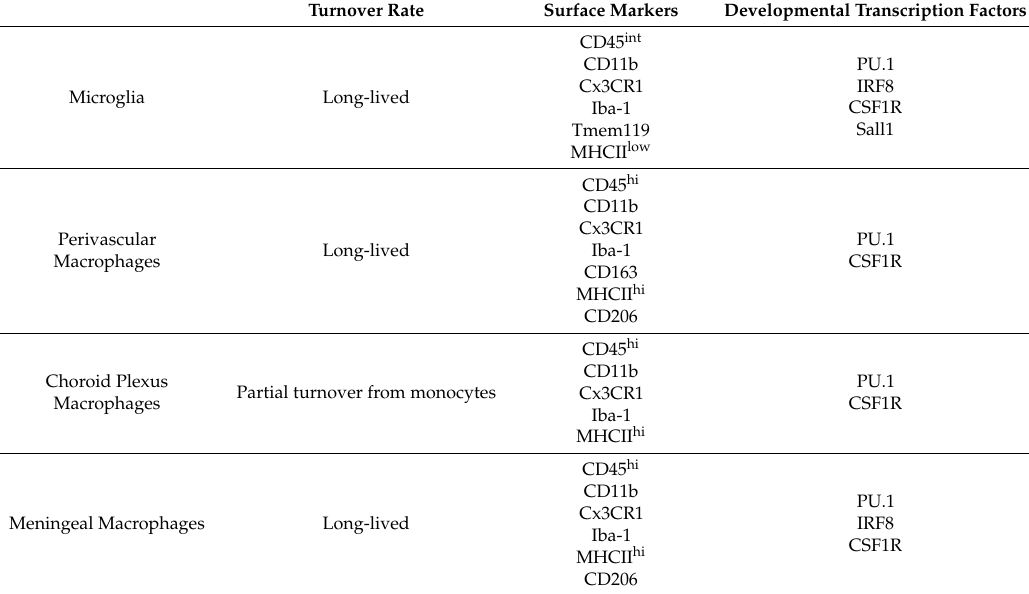
Table 1. Distinguishing features of non-parenchymal macrophages and